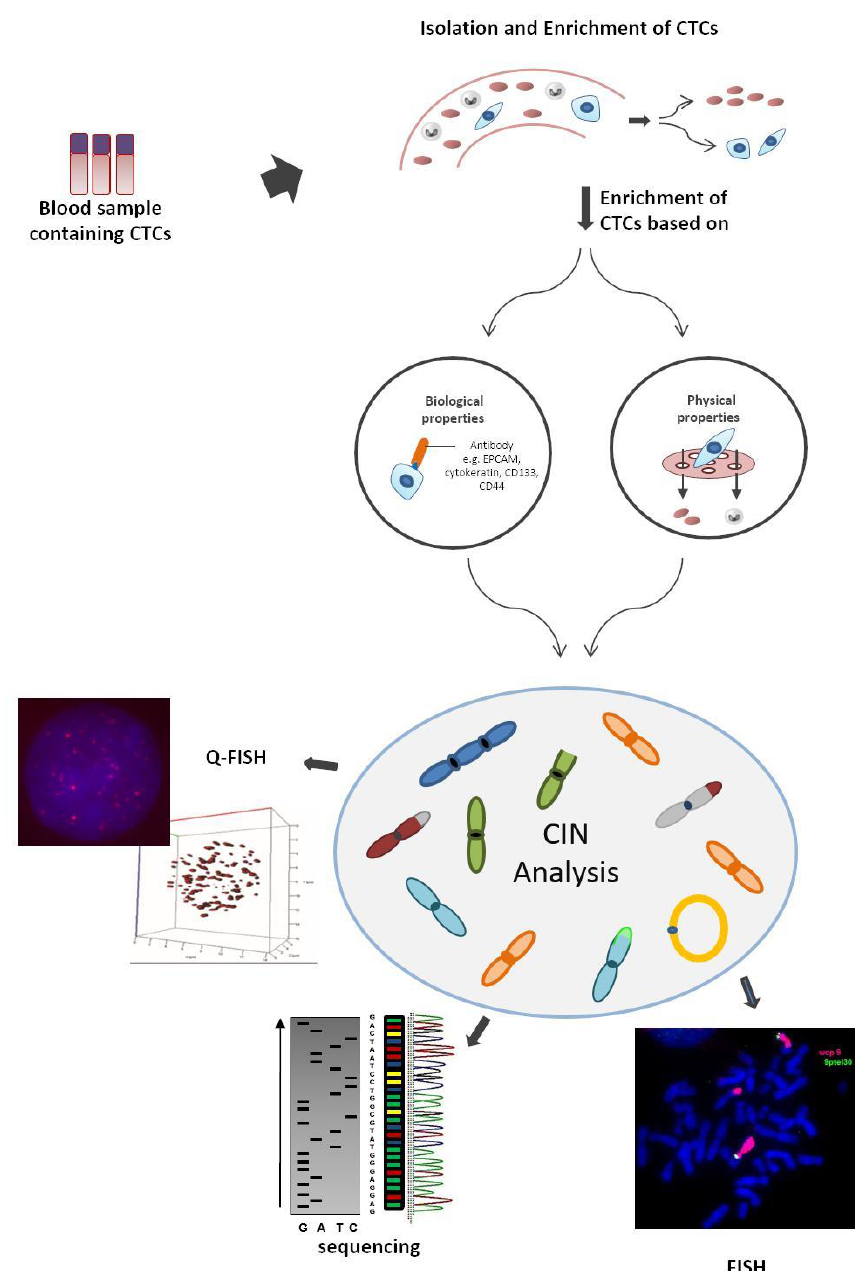
Figure 1. Steps required to obtain circulating tumor cells (CTCs) for chromosomal instability (CIN) analyses and techniques used to characterize chromosome instability. Collection of peripheral blood followed by isolation and enrichment of CTCs based on biological properties (expression of protein markers) or physical properties (size, density, deformability, or electrical charges). After that, CIN analysis can be performed using techniques such as fluorescence in situ hybridization (FISH), whole-exome sequencing, Quantitative fluorescence in situ hybridization (Q-FISH), and next-generation sequencing, among